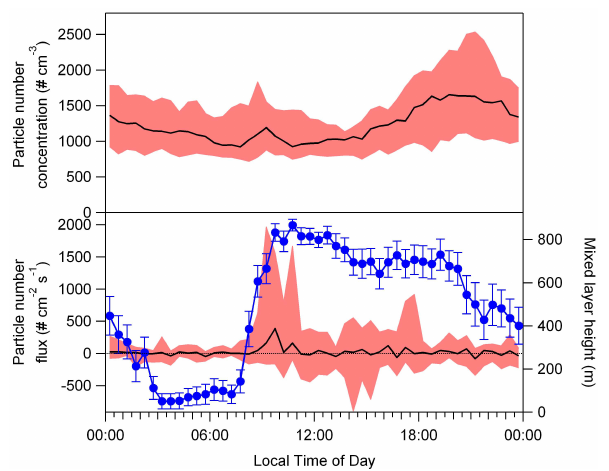
Fig. 3. Diurnal variation of particle number concentration (top) and flux (bottom) measured at the GAW tower plotted as median val- ues at given times of day (black line) and the inter-quartile ranges (red shaded region). Also shown is the diurnal average mixed layer height derived from the lidars aerosol backscatter data (blue trace). The zero line on the particle number flux axis also marks the height of the flux measurements on the GAW tower above the lidar mea- surements on the mixed layer height axis. Error bars are standard error.